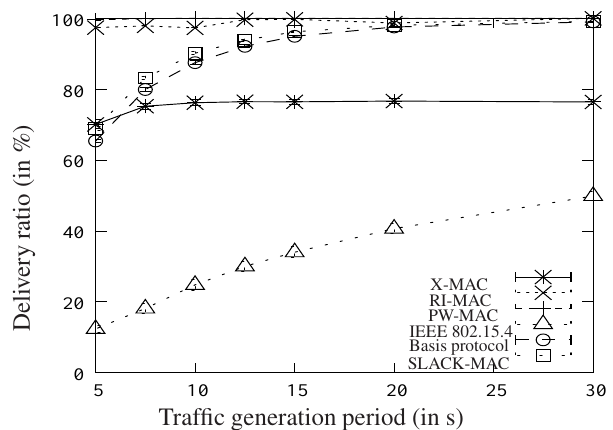
Figure 6. Delivery ratio as a function of the traffic generation period, for a duty-cycle of 1 %, and for several protocols.